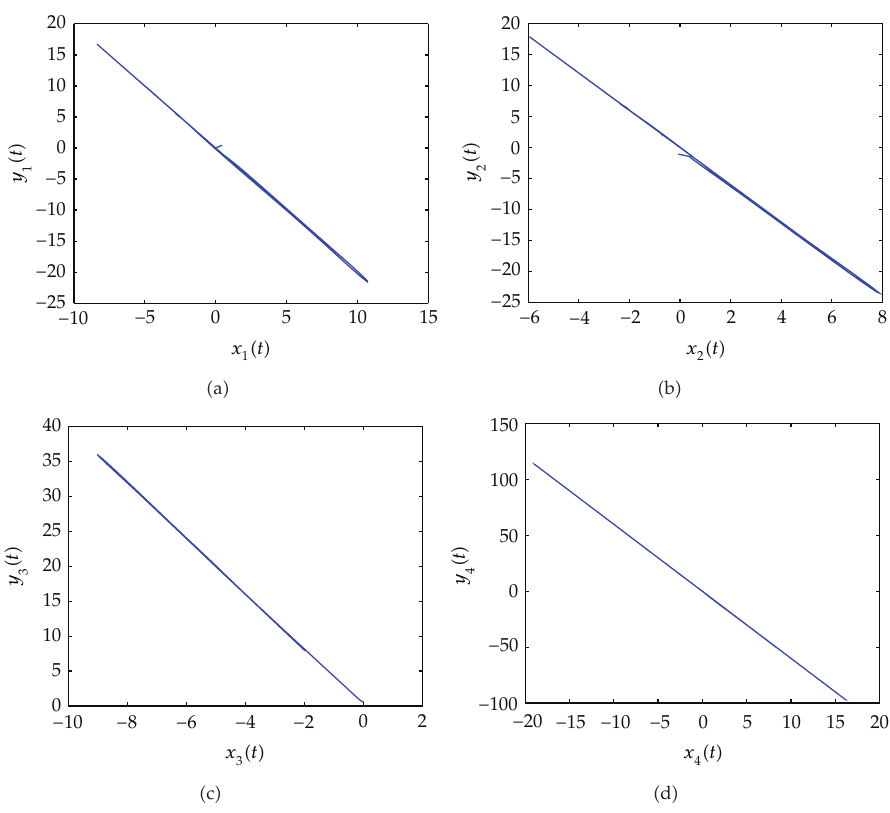
Figure 7: Signals after synchronization under control law (cid:6) 3.15 (cid:7) .